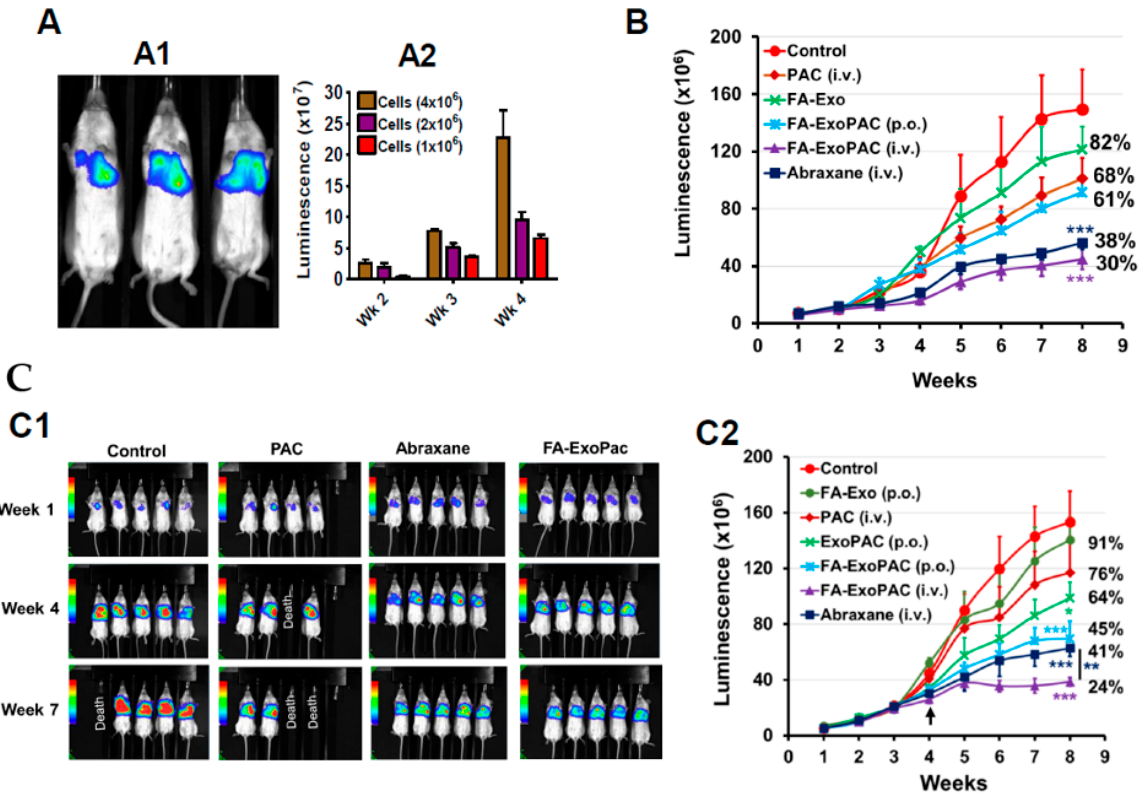
Figure 5. Antitumor activity against orthotopic xenografts. Detection of orthotopic lung cancer using bioluminescent A549-Red-luc cells. ( A ) A1: image of live animals after 27 d of inoculation with 2 × 10 6 cells (3 mice/group). A2: Mean of bioluminescence signals. ( B ) Inhibition of A549 orthotopic lung tumors in NOD Scid female mice ( n = 10) by i.v. paclitaxel (PAC), i.v. Abraxane, and p.o. ExoPAC and p.o. FA-ExoPAC (three doses weekly), all given at 6 mg/kg. FA-Exo was used as control for FA-ExoPAC. ( C ) Inhibition of A549 orthotopic lung tumors in NOD Scid female mice ( n = 10) by i.v. PAC, Abraxane, FA-ExoPAC (once weekly) and p.o. ExoPAC and FA-ExoPAC (three doses weekly), all given at 4 mg/kg until three wks, then switched to 8 mg/kg, as indicated by an arrow in C2. Representative images of animals at different time points in the indicated treatment groups (C1) and time-dependent tumor inhibition (C2). Statistical analysis was performed using the Student’s t -test. *, p < 0.05; **, p < 0.01; ***, p <